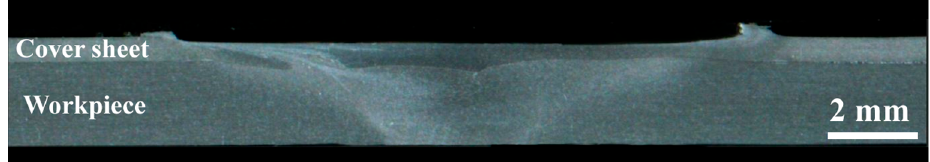
Figure 3. Cross section of the CFSW joint.